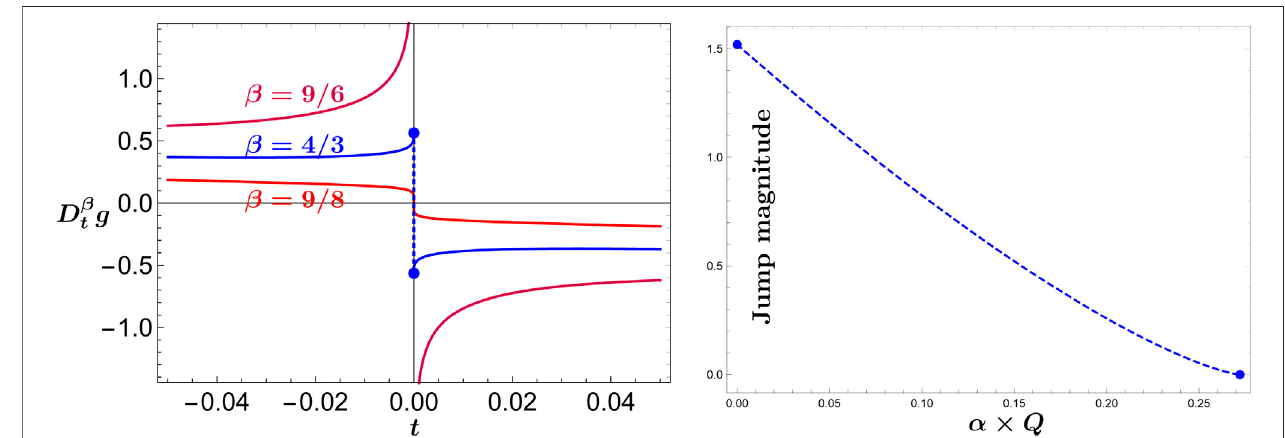
FIGURE1| Leftpanel:Thebehavioroffractionalderivatives D β t g for ß equalto9/6(purpleline),9/8(redline),and4/3(blueline)nearthecriticalpointofchargedAdS black hole surrounded by quintessence. Input: Q α (cid:2) 0 . 55. Right panel: Jump magnitude near the critical point as a function of a for β (cid:2) 4 / 3.